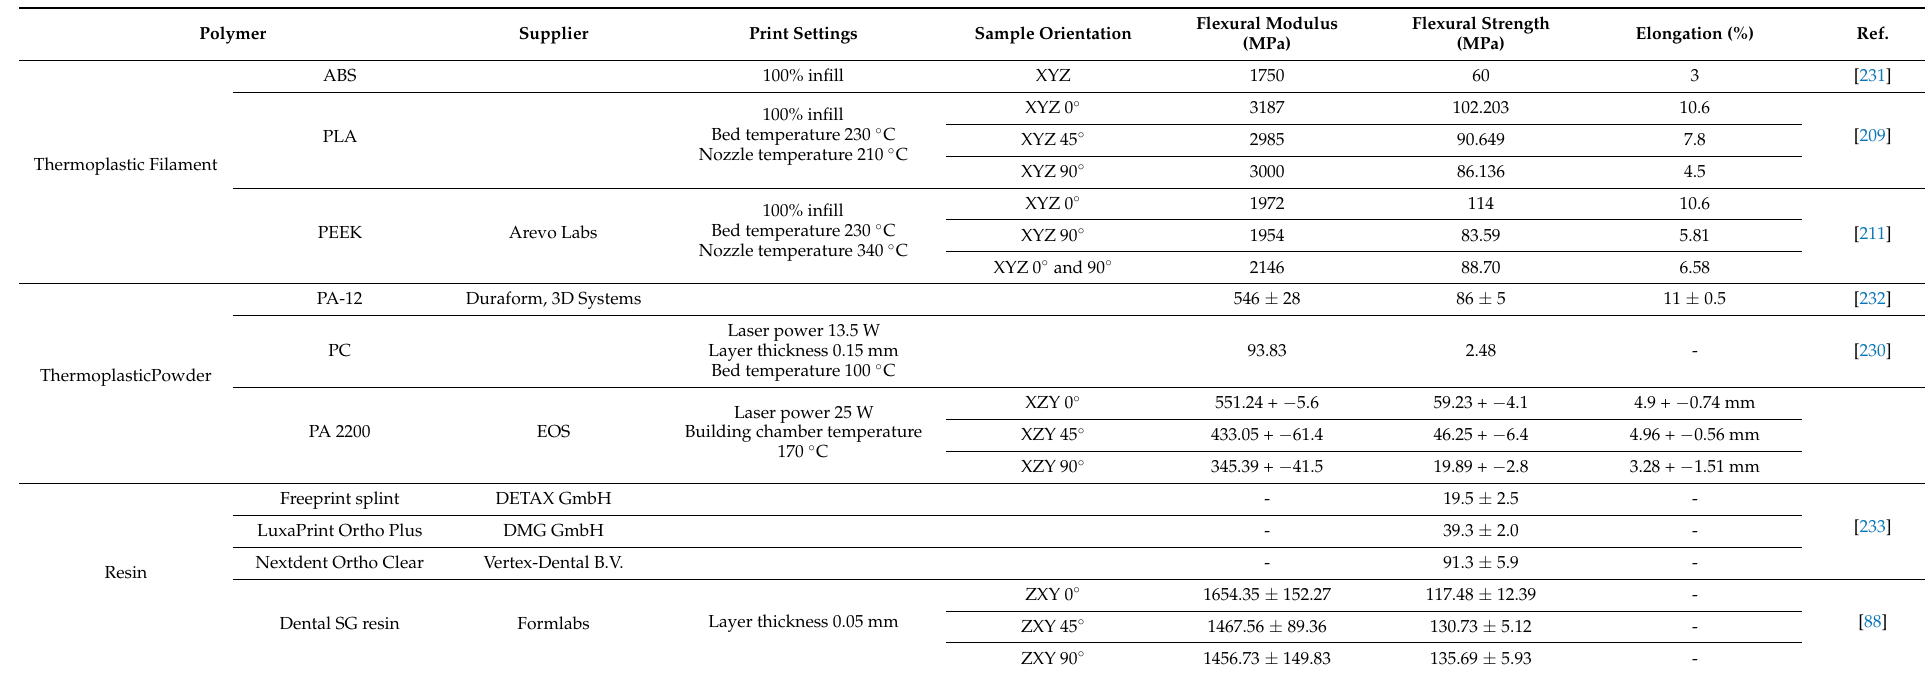
Table 6. A summary of the flexural properties of a few common print materials for all three, FDM, SLS, and SLA, printing techniques. Information such as print setting, print orientation, flexural modulus, flexural strength, and elongation at break are